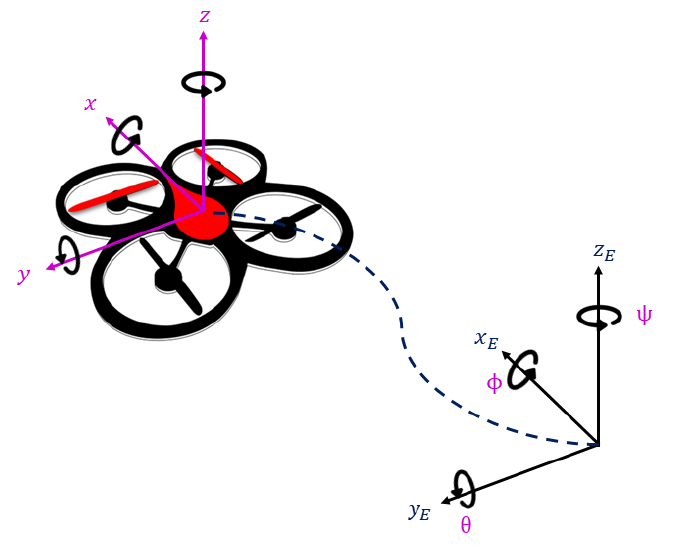
Figure 11. Drone coordinate